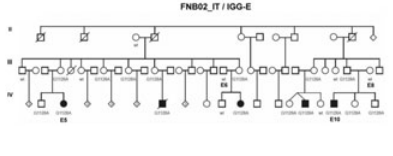
Figura 1. Pedigree della famiglia IGG-E in cui segrega la mutazione G1128A del gene ALK; wt: wild